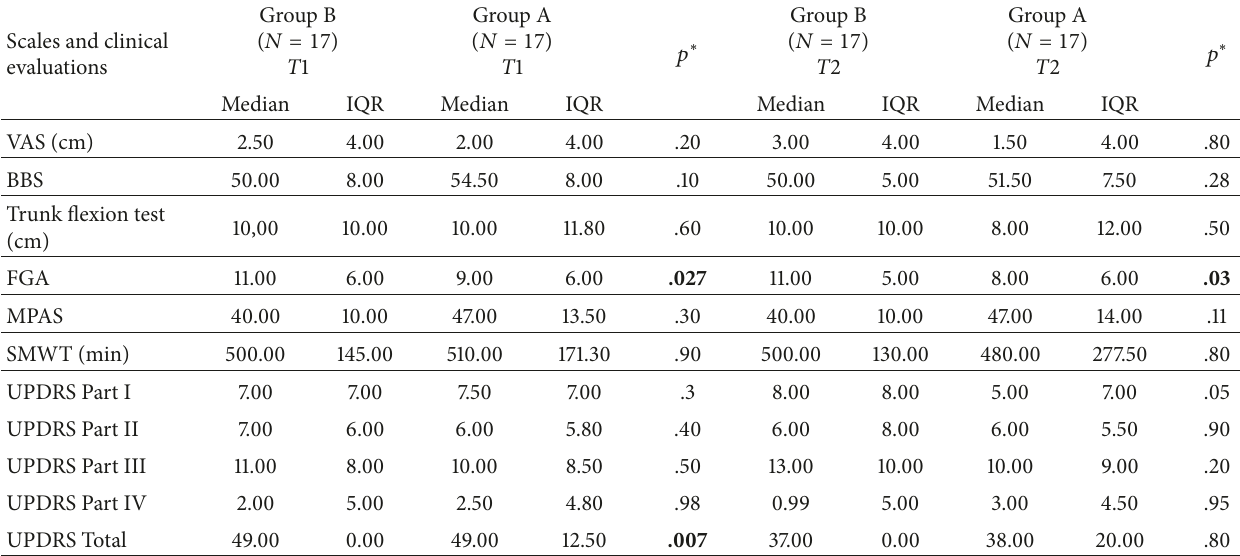
Table 3: Scales and clinical evaluation: comparison between groups at T 1 (end of treatment) and T 2 (follow-up) for pain, mobility (balance and posture), and disability (median and IQR, 𝑝 < .05 ). Scales and clinical